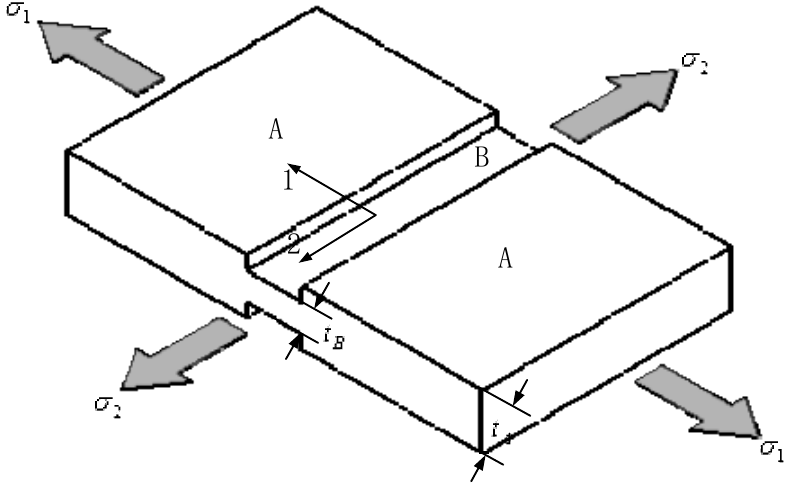
Figure 1. Schematic diagram of groove model.